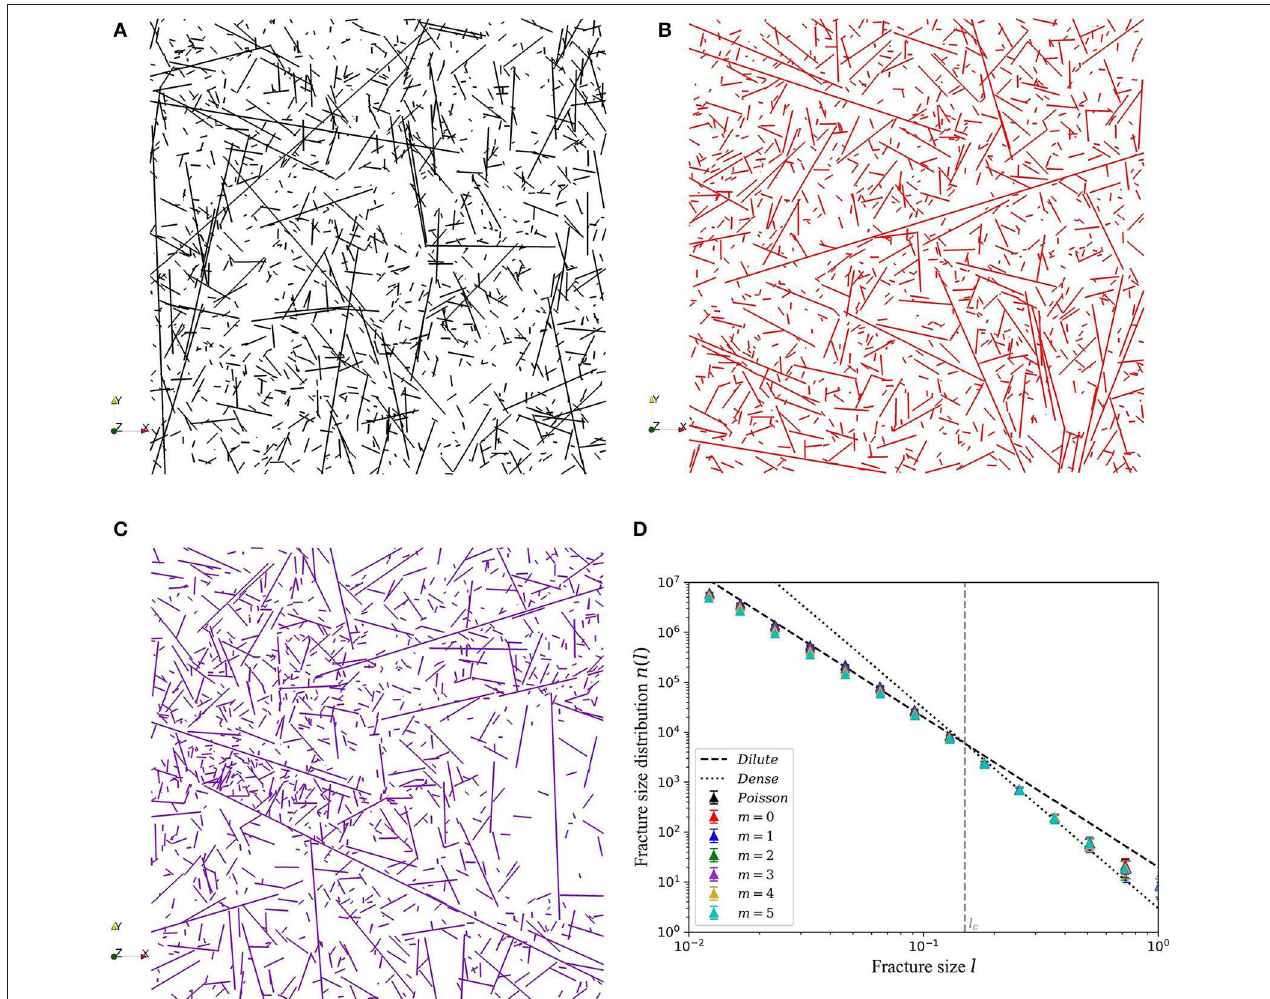
FIGURE 2 | 2D slices of three-dimensional (A) Poisson, (B) stress-independent UFM ( m = 0 ), and (C) stress-driven UFM ( m = 3 ) models, and (D) associated size distributions ( m ∈ [ 0 , 5 ]).